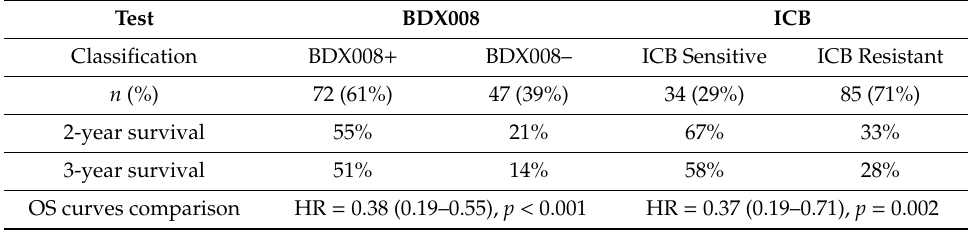
Table 2. Performance of BDX008 and immune checkpoint blockade (ICB) tests in development cohort. Test BDX008 ICB Classification BDX008